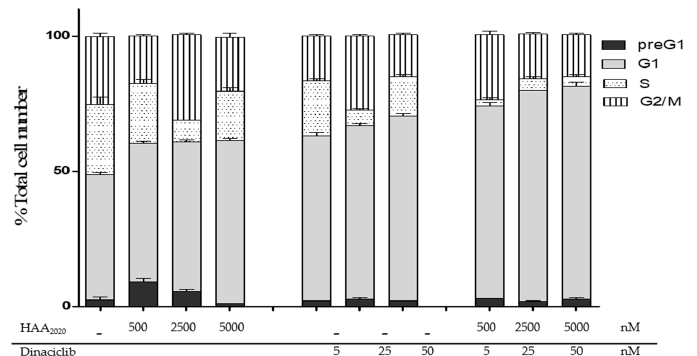
Figure 5. Cell cycle analysis in MCF7 cells treated for 24 h with either HAA 2020 (500, 2500, 5000 nM), dinaciclib (5, 25, 50 nM) or their combinations. Cell cycle phases: preG 1 , G 1 , S, and G 2 /M. Data is represented as Mean ± SD ( n = 3, two independent experiments). Histograms of 20,000 events are presented in supplementary material S4.